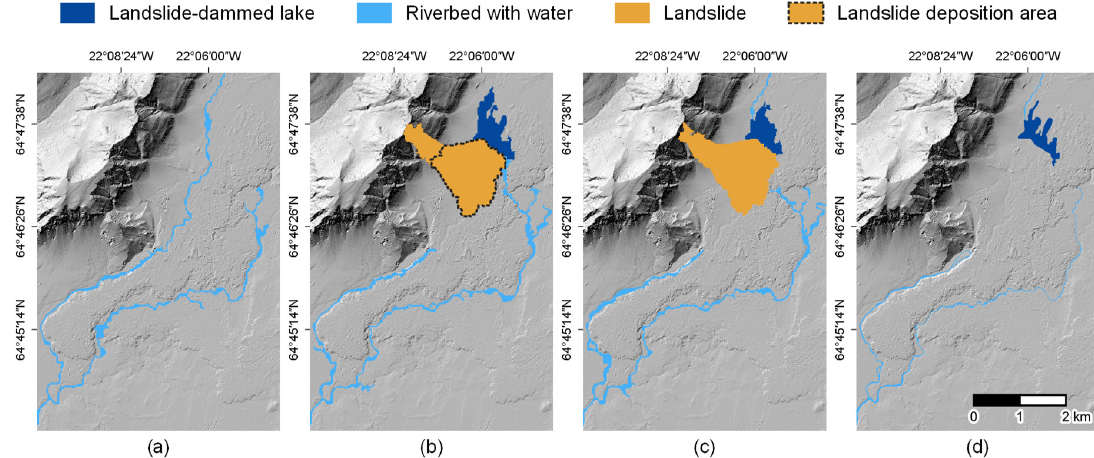
Figure 6. Object-based geomorphological feature mapping using Sentinel-1 and Sentinel-2 datasets. ( a ) shows the riverbed with water before the Hítardalur landslide using the pre-event Sentinel-2 image only; ( b ) shows the landslide, the landslide deposition area, the landslide-dammed lake, and the (now partly interrupted) riverbeds with water after the landslide event in 2018; ( c ) shows the landslide, the landslide-dammed lake, and the riverbeds with water in 2019; ( d ) shows the reference map from National Land Survey of Iceland IS 50V 24 September 2019 Vatnafar Flakar (© NLSI) [77]. The hillshade derived from the ArcticDEM was used as a background layer.